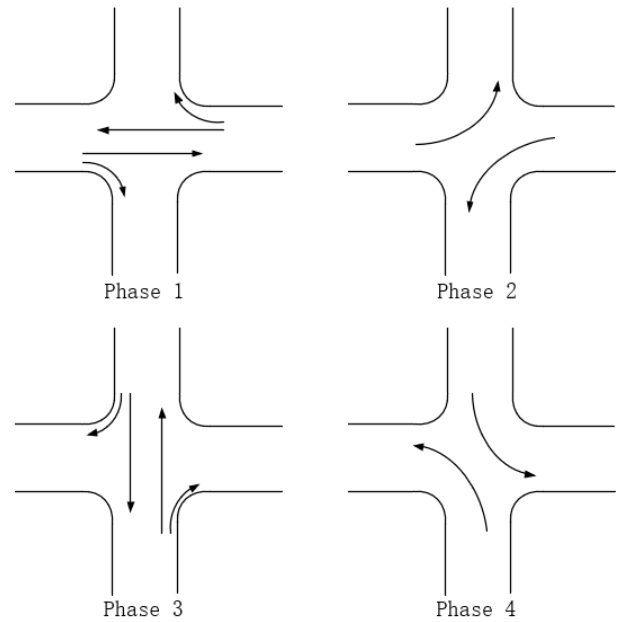
Figure 3. The four-phase